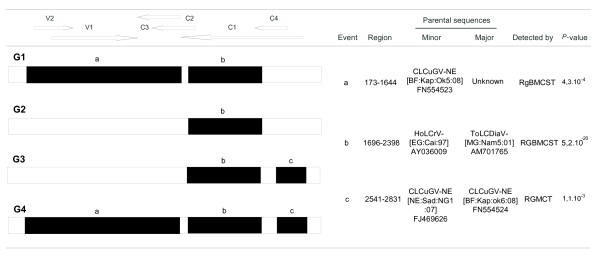
Recombinant regions (a, b and c) detected within the African isolates of CLCuGV sequences using RDP3. Four genetic groups (G1 to G4) have been defined on the presence or absence of recombination events. The genome at the top of the figure corresponds to the schematic representation of sequences below. Region coordinates are nucleotide positions of detected recombination breakpoints in the multiple sequence alignment used to detect recombination. Wherever possible, parental sequences are identified. "Major" and "Minor" parents are sequences that were used, along with the indicated recombinant sequence, to identify recombination. Whereas for each identified event the minor parent is apparently the contributor of the sequence within the indicated region, the major parent is the apparent contributor of the rest of the sequence. Note that the identified "parental sequences" are not the actual parents but are simply those sequences most similar to the actual parents in the analysed dataset. Recombinant regions and parental viruses were identified using the RDP (R), GENECONV (G), BOOTSCAN (B), MAXIMUM CHI SQUARE (M), CHIMAERA (C), SISTER SCAN (S) and 3Seq (T) methods. Whereas upper case letters imply a method detected recombination with a multiple comparison corrected P-value < 0.01, lower case letters imply the method detected recombination with a multiple comparison corrected P-value <0.05 but > = 0.01.